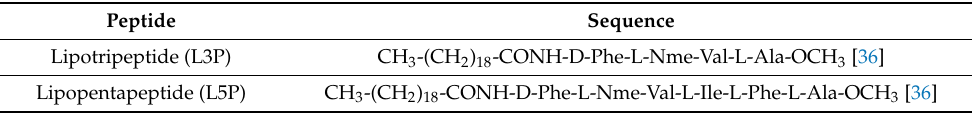
Table 2. MAP epitopes used as coating antigens in H-MELISA analyses, and their sequences. Peptide